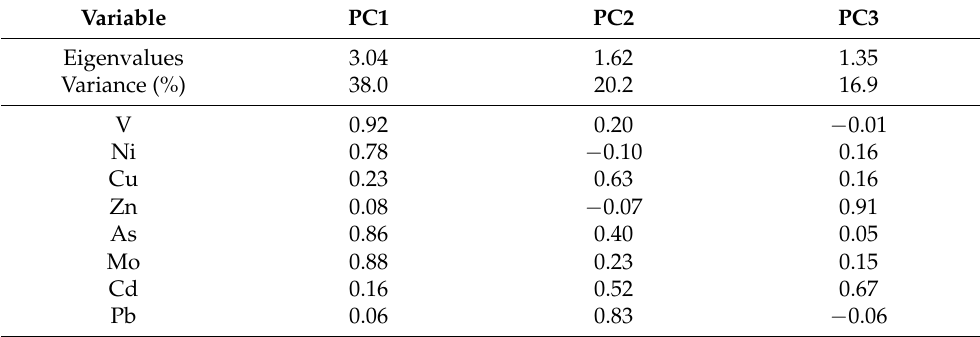
Table 3. Varimax rotated component matrix for dissolved HMs of the upper TGR